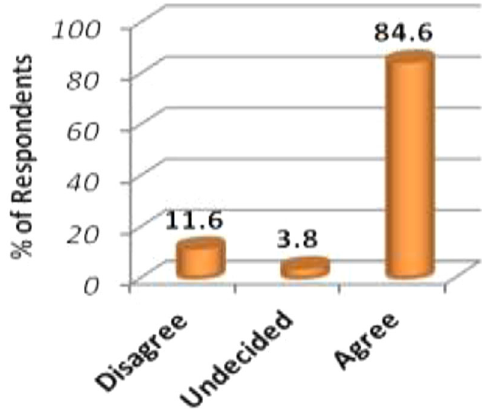
Fig. 2 A test on whether or not the Multinationals in Rivers State Nigeria obeyed environmental policies.